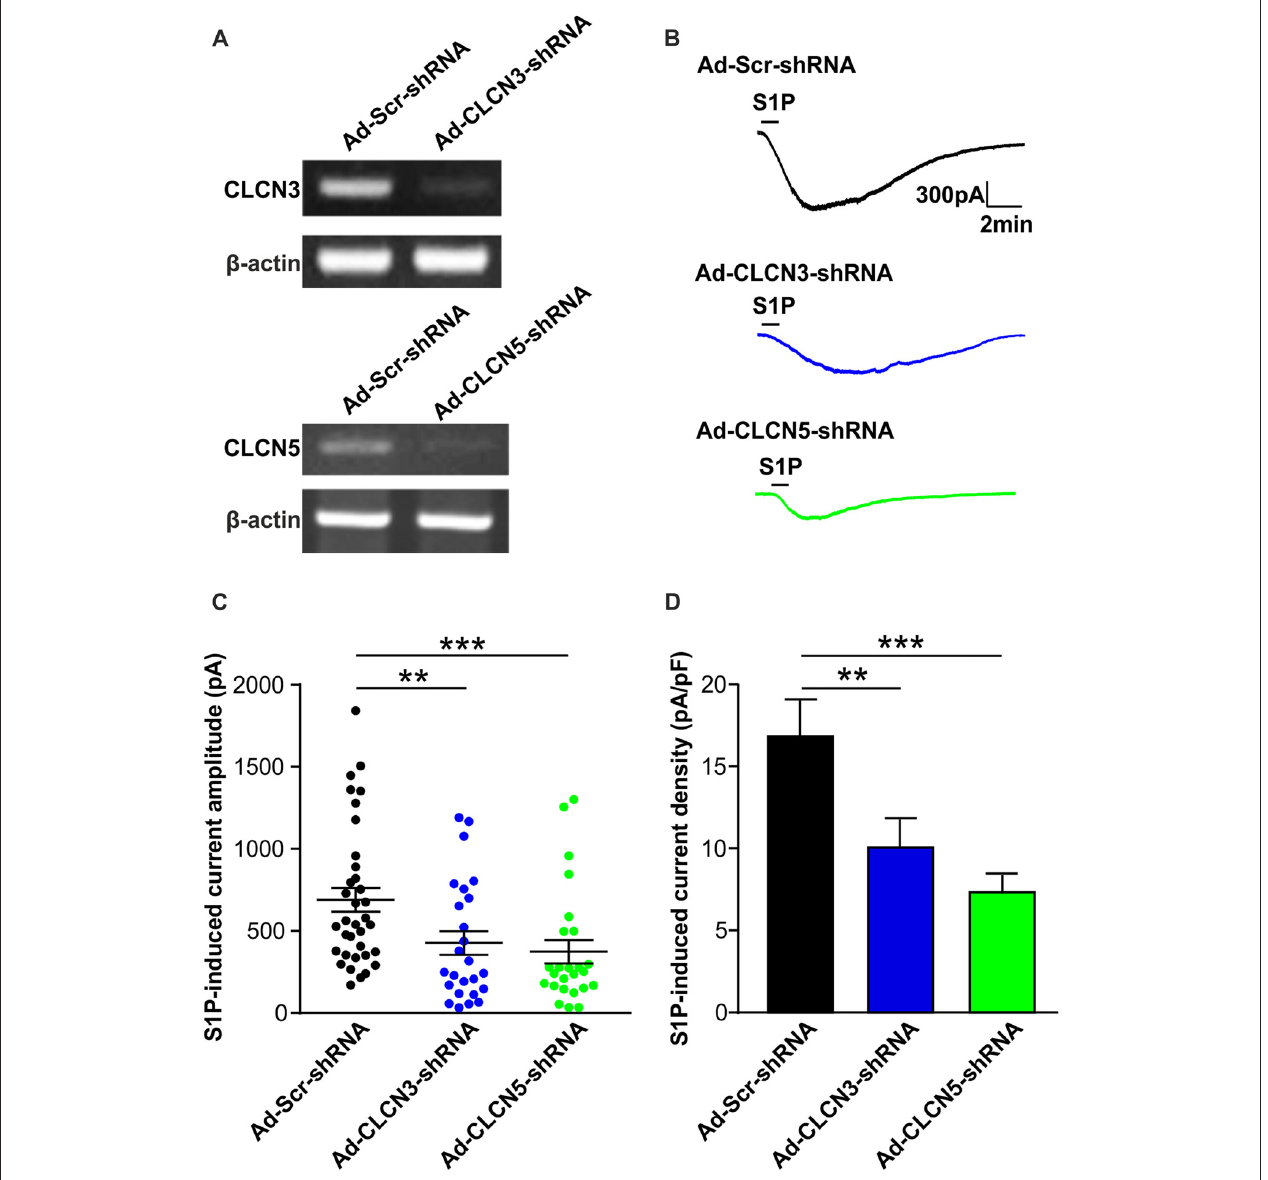
FIGURE 2 | Adenovirus-mediated underexpression of CLCN3 or CLCN5 by shRNA reduces S1P-induced Cl − current in mouse sensory neurons. (A) Cultured DRG neurons were infected with scrambled shRNA adenovirus (Ad-GFP-U6-scrambled shRNA) or adenovirus carrying specific shRNA against CLCN3 (Ad-GFP-U6-CLCN3 shRNA) or CLCN5 (Ad-GFP-U6-CLCN5 shRNA). Representative RT-PCR results from three independent experiments showed that Clcn3 and Clcn5 mRNA levels were reduced by their corresponding specific shRNA 3 days after adenoviral infection. (B) Representative whole-cell voltage clamp recording of inward Cl − currents induced by S1P (1 µ M, 1 min) from DRG neurons infected with Ad-Scr-shRNA, Ad-CLCN3-shRNA or Ad-CLCN5-shRNA adenovirus at − 60 mV holding potential. (C) Dot-plot graph showing the amplitude of S1P -induced inward current in Ad-Scr-shRNA ( n = 35), Ad-CLCN3-shRNA ( n = 25) and Ad-CLCN5-shRNA ( n = 25) groups. Each dot represents a single cell and mean and SEM are indicated. Note the reduced amplitude of S1P-activated inward current by Ad-CLCN3-shRNA or Ad-CLCN5-shRNA in DRG neurons 3 days after viral infection (Mann-Whitney U test, Ad-Scr-shRNA vs. Ad-CLCN3-shRNA ∗∗ p < 0.01, Ad-Scr-shRNA vs. Ad-CLCN5 shRNA ∗∗∗ p < 0.001). (D) Quantitative comparison of S1P-induced current density (current amplitude/cell capacitance, pA/pF) in DRG neurons after adenoviral infection of Ad-Scr-shRNA, Ad-CLCN3-shRNA or Ad-CLCN5-shRNA. Adenovirus-mediated knockdown of CLCN3 or CLCN5 by shRNA significantly reduced S1P-induced current density in DRG neurons (Mann-Whitney U test, Ad-Scr-shRNA vs. Ad-CLCN3-shRNA ∗∗ p < 0.01, Ad-Scr-shRNA vs. Ad-CLCN5 shRNA ∗∗∗ p < 0.001).